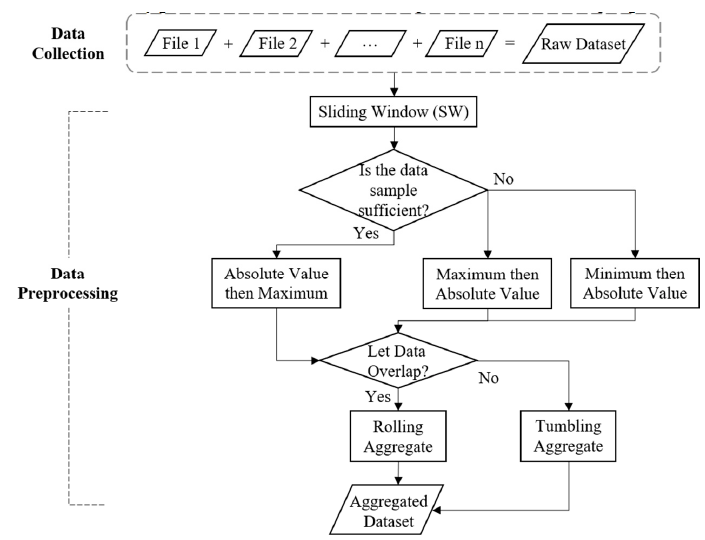
Figure 2. Data collection and preprocessing. Energies 2019 , 12 , x FOR PEER REVIEW